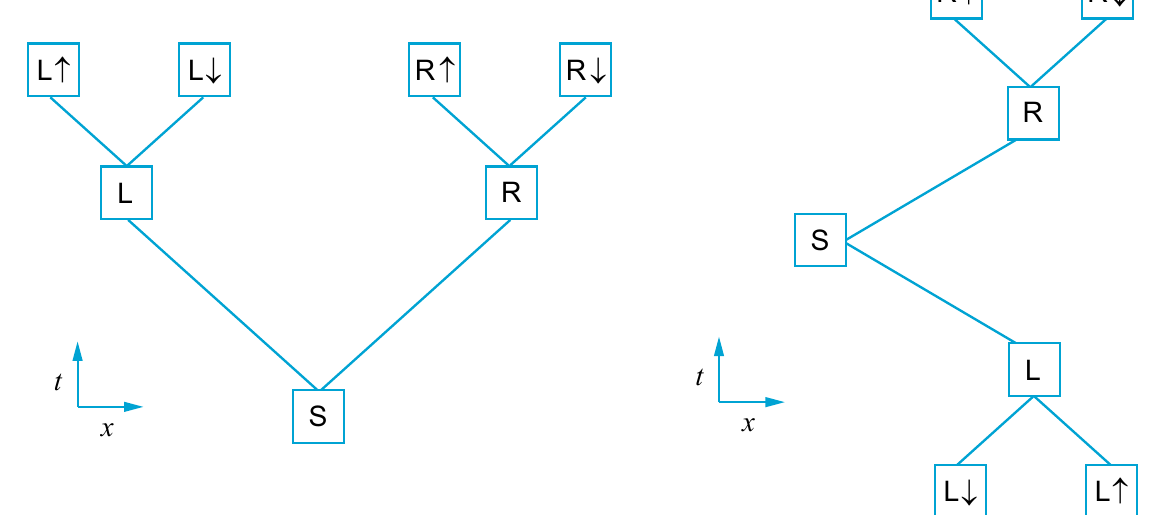
Figure 2: Spacetime diagram of the sideways Einstein- Podolsky-Rosen-Bell